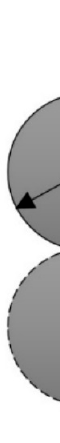
Figure 9. Cylinders in contact under load P and a fixed point.